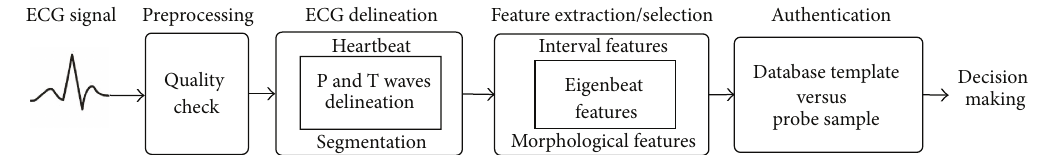
Figure 4: Schematic of a biometric recognition system for identifying individuals based on their electrocardiograms.